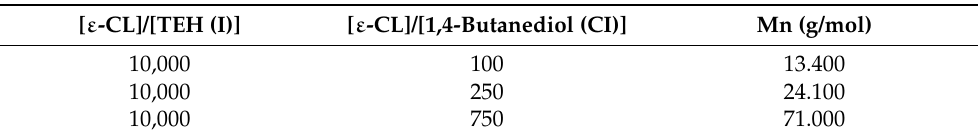
Table 1. Different molar ratios of initiator and co-initiator used for the synthesis of PCL polyesters with different molecular weights.